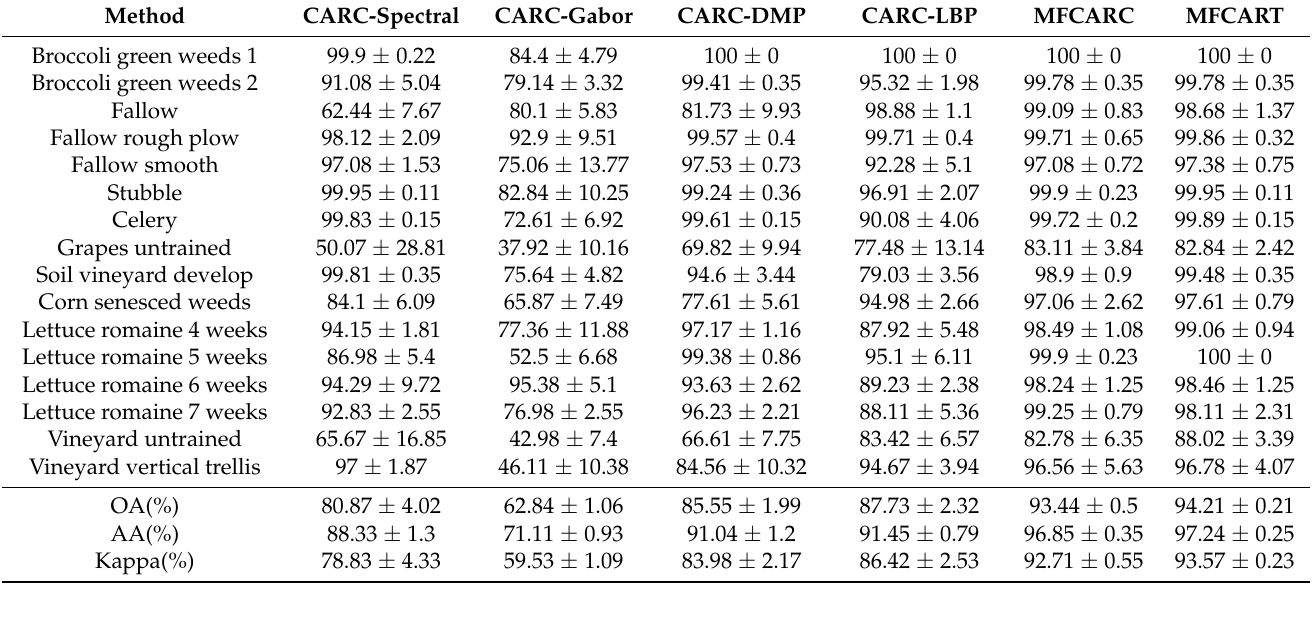
Table 6. Classification accuracy (%) of the proposed CARC and CART with different single features and multiple features for the Salinas Data. Table 7. Classification accuracy (%) of different classifiers for the Indian Pines data set.